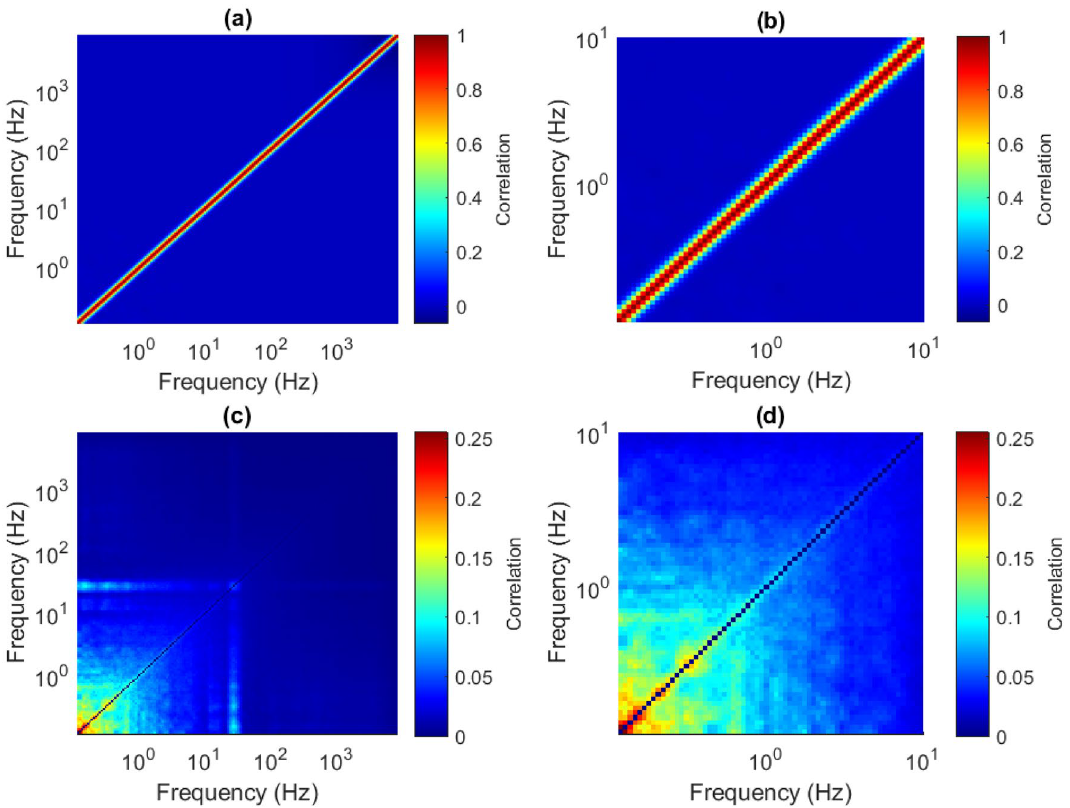
Figure 12. ( a ) Mean ISPCM for white noise process of length 500 s, L = 1015 . ( b ) Same plot as ( a ), but